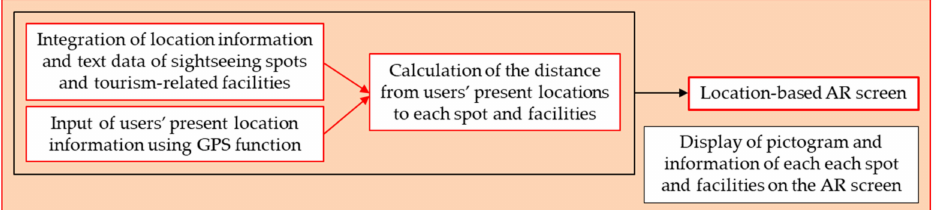
Figure 2. Sequence of steps for location-based AR.